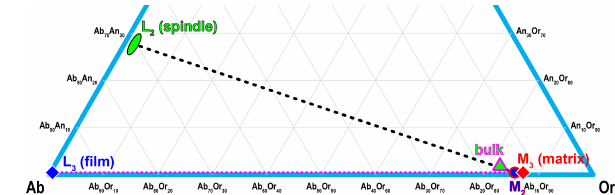
Figure 10. The compositions of L 2 (oligoclase spindle), L 3 (albite film) and M 3 (orthoclase matrix) are plotted on the ternary diagram, along with M 2 (average of L 3 and M 3 ) and the bulk composition (average of L 2 , L 3 and M 3 ) of the RLS. The composition of Or 96 reported by Liu et al. (2018) has to be incorrect as it places the RLS on the solvus far below the closure temperature for the exsolution